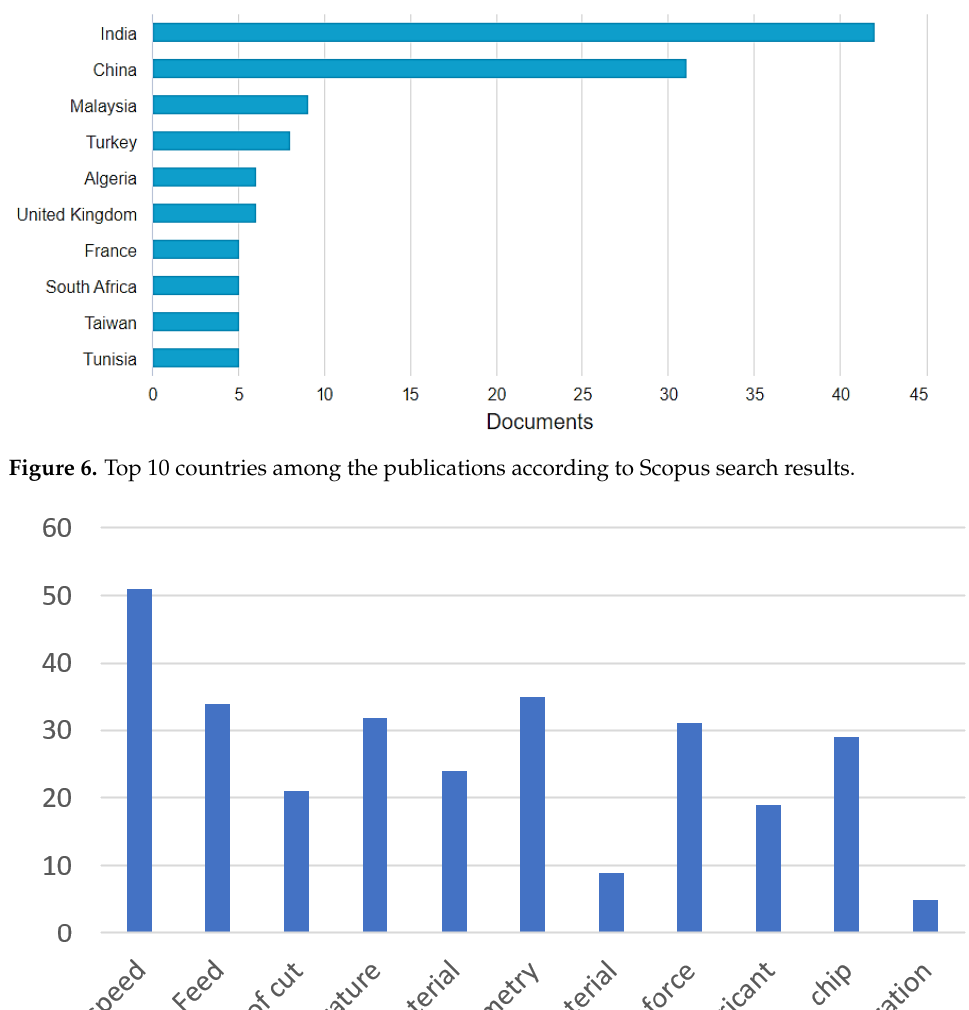
Figure 5. Fields of the publications according to Scopus search results .